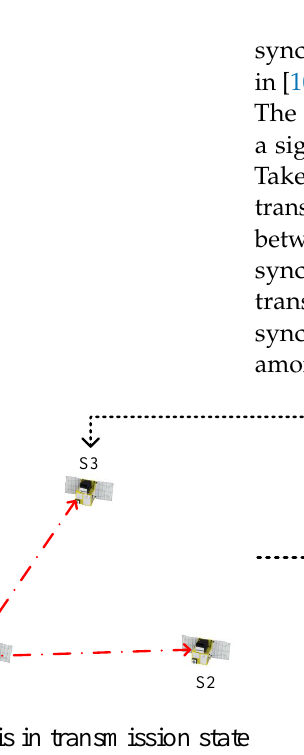
Figure 9. Clock synchronization scheme.